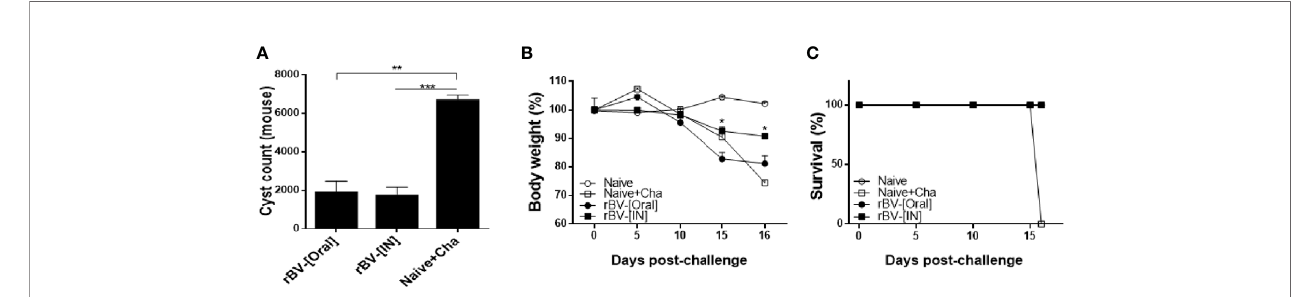
FIGURE 7 | Complete protection against T. gondii ME49. Mice were challenge-infected with 50 LD 50 T. gondii ME49 cysts 4 weeksafter the fi nal immunization. Mice were sacri fi ced 16 dayspost-infection and brain tissues were harvested to isolate andenumeratethe cysts (A) . Bodyweight changes (B) and survivalrate (C) were monitoreddaily up to 16 dpi.Data are presented as mean ± SDand asterisksindicate statistical differences between groups. (* P < 0.05, ** P < 0.01, *** P